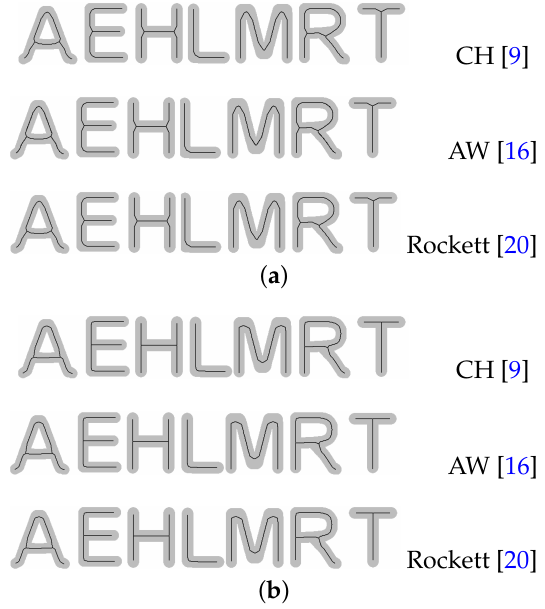
Figure 14. Thinning results ( a ) without and ( b ) with the RHDP process are obtained by the three fully-parallel thinning algorithms involved in the proposed approach for comparisons. The biased skeletons of ( b ) are much less than those of ( a ).